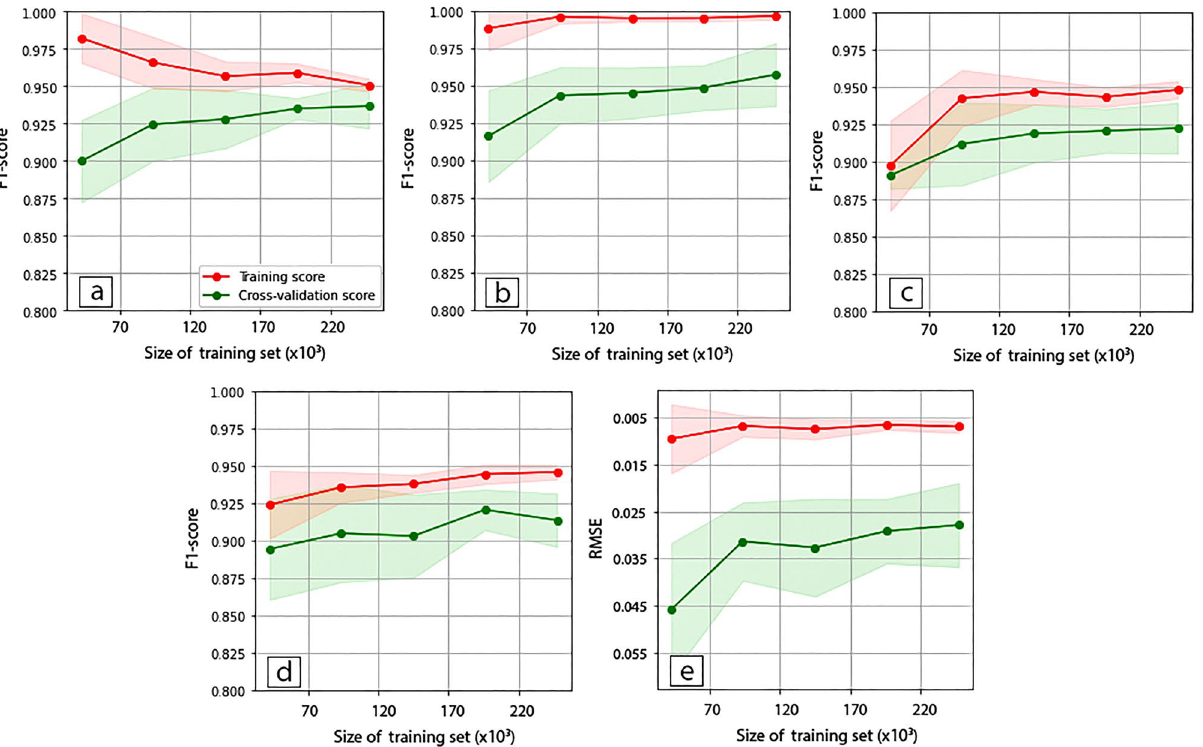
Figure 12. Performance learning curves of the ML classifiers, ( a ) LG, ( b ) DT, ( c ) SVM, ( d ) KNN and ( e ) DNN model with the training (red) and cross-validation score